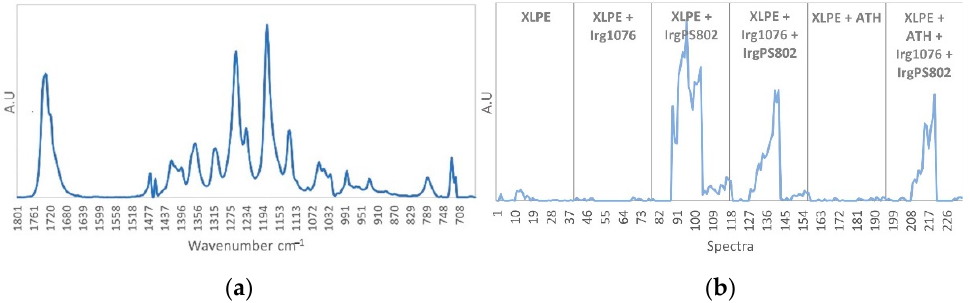
Figure 13. ( a ) IrgPS802 degradation products pure spectrum. ( b ) IrgPS802 degradation products concentration profile.